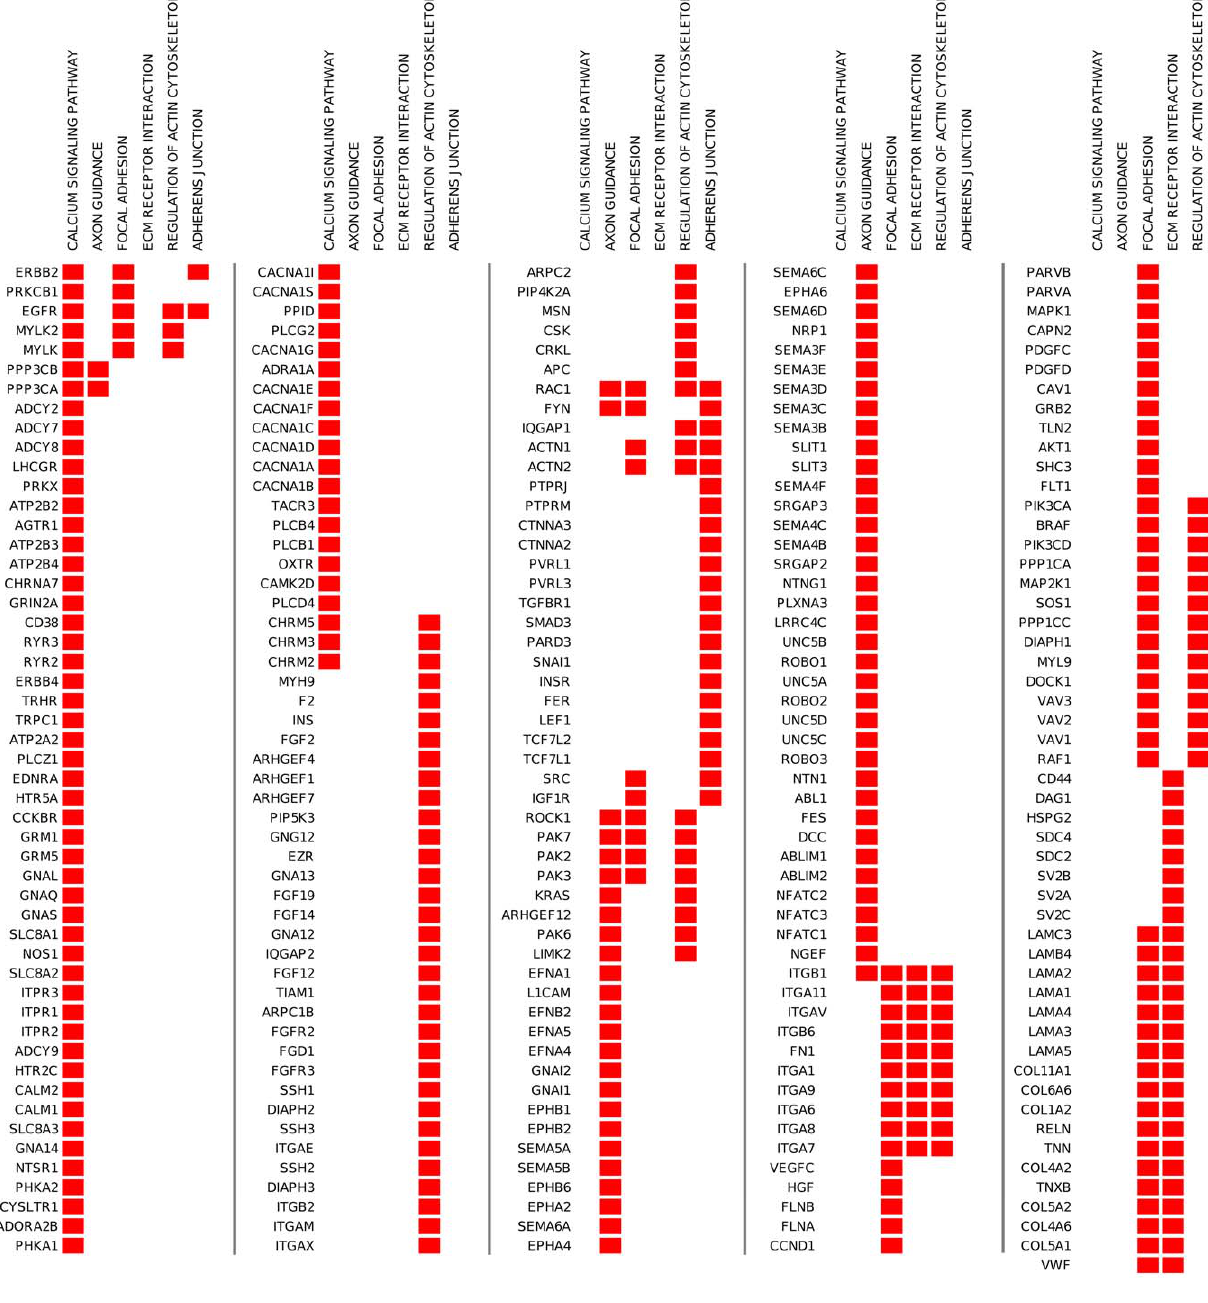
Figure 4. Leading edge genes of the high F ST enriched KEGG pathways identified by GSEA. Genes are indicated by gene symbols. Red box marks the presence of that gene, as leading edge gene, in that